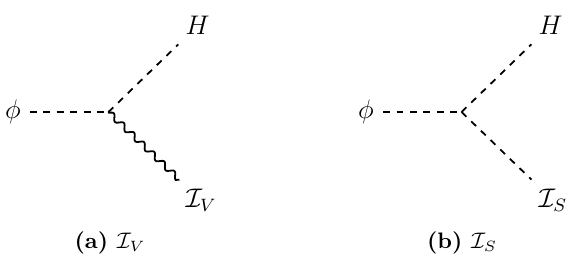
Figure 10. Mono- H + E miss